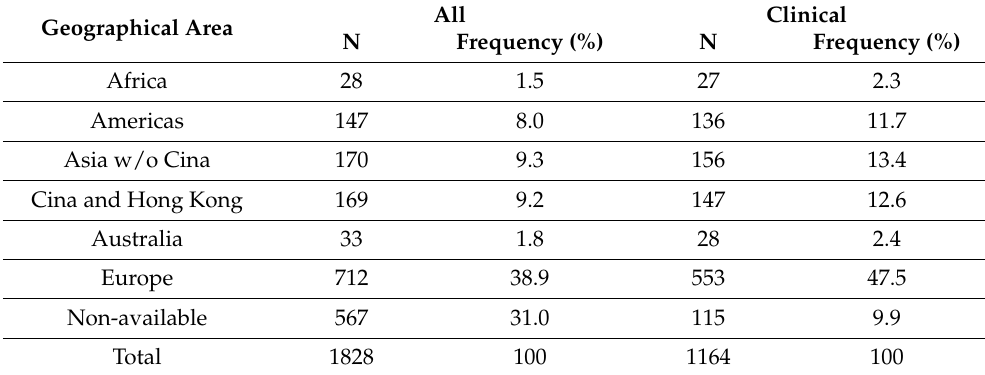
Table 2. Distribution of S. agalactiae sequences in NPDIB by geographical area of reporting. Geographical Area